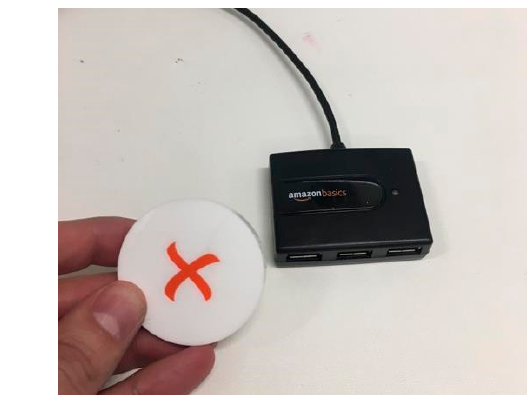
Figure 1. Exhibition in a box co-design tool.